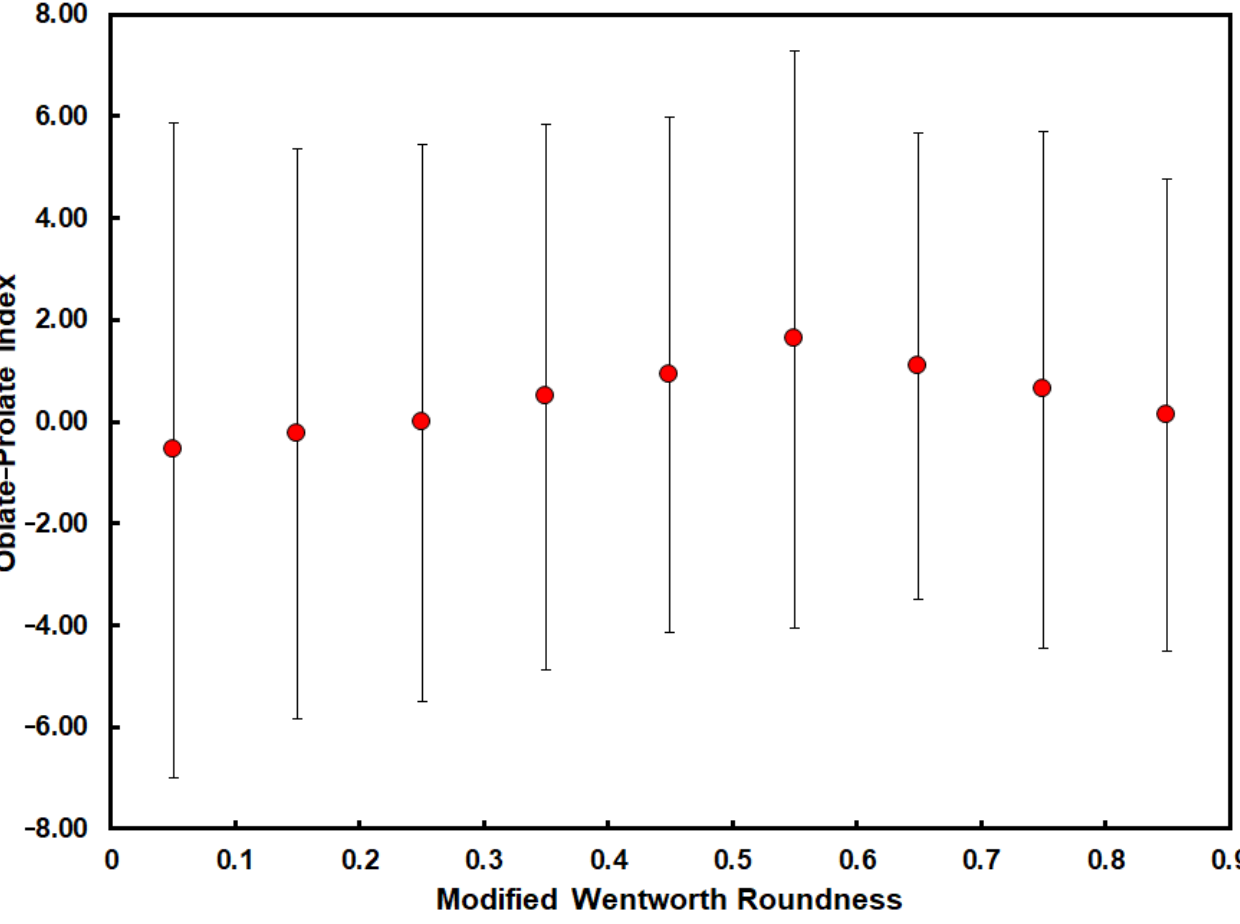
Figure 18. The Oblate–Prolate Index of fluvial gravels of Navilawa Monzonite from Stations 1–7 along the Sabeto River of western Viti Levu, Fiji as a function of their Modified Wentworth Roundness. The data points are expressed with an uncertainty of ±1 s .